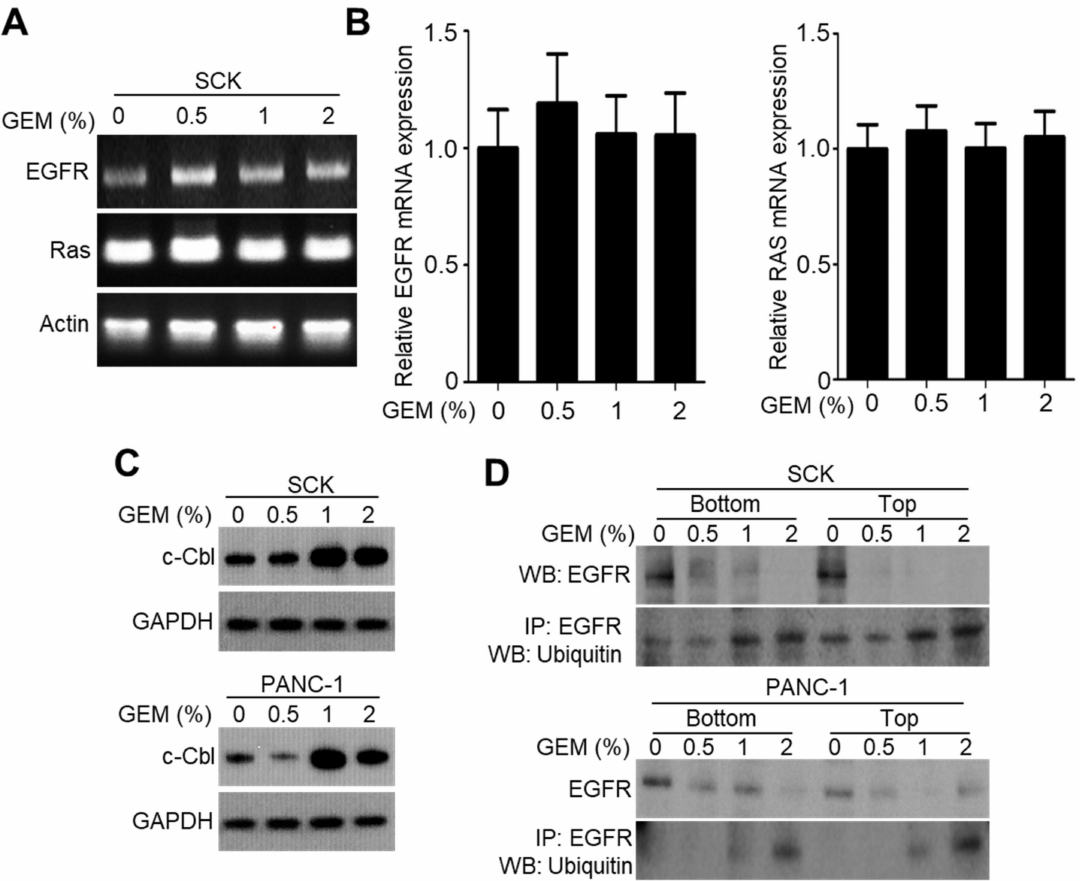
Figure 3. Gemcitabine-eluting membrane (GEM) implantation reduces EGFR expression by promoting c-CBL-mediated EGFR degradation. ( A , B ) Reverse transcription–polymerase chain reaction was performed to evaluate EGFR expression in SCK tumor lysates after implantation with GEM containing the indicated concentrations of gemcitabine. ( C ) Western blot analysis of c-CBL in SCK and PANC-1 tumor lysates after GEM implantation containing the indicated concentrations of gemcitabine. ( D ) The level of ubiquitinated EGFR was determined by immunoprecipitation using an anti-EGFR